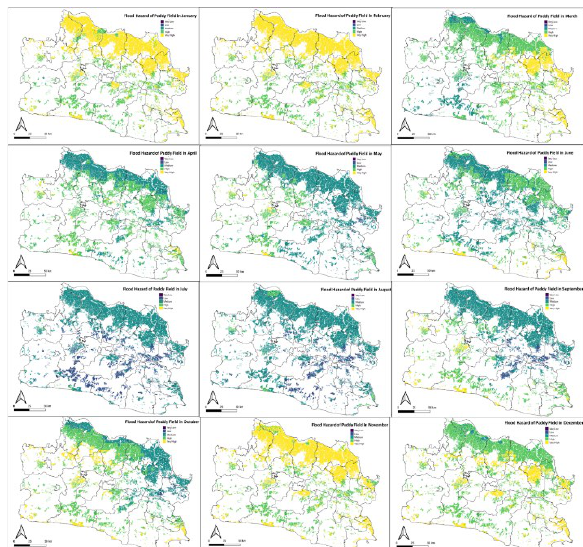
Figure 4 . Flood hazard model in the rice fields every month in 2021